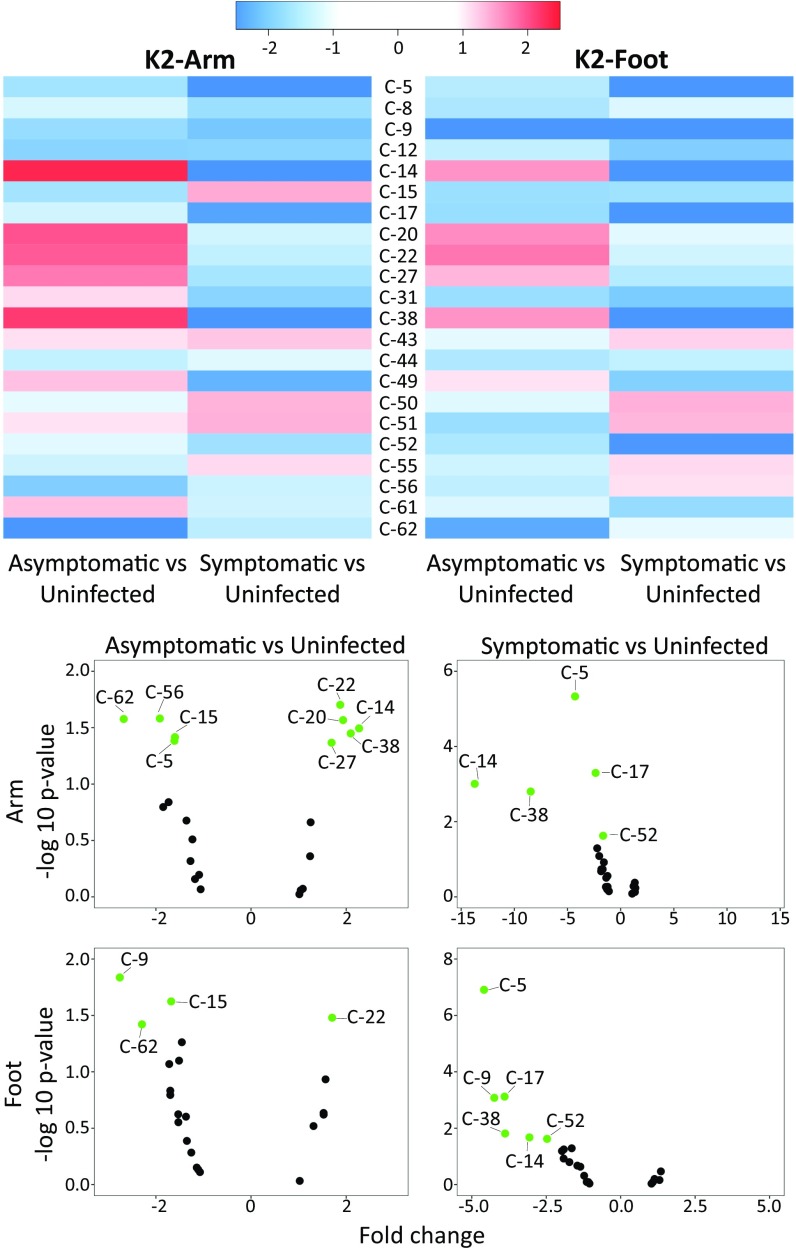
(Top) Heatmap showing the fold-change of individual compounds in asymptomatic and symptomatic individuals relative to those in uninfected individuals for K2-arm and K2-foot. (Bottom) Volcano plots showing changes in individual compounds in asymptomatic and symptomatic individuals, relative to those in uninfected individuals, with compounds significantly up- or down-regulated shown in green (P < 0.05 and absolute fold change >1.5). Nonsignificant regulated compounds with absolute fold change <1.5 shown in black. (Compound IDs are listed in Table 2.)